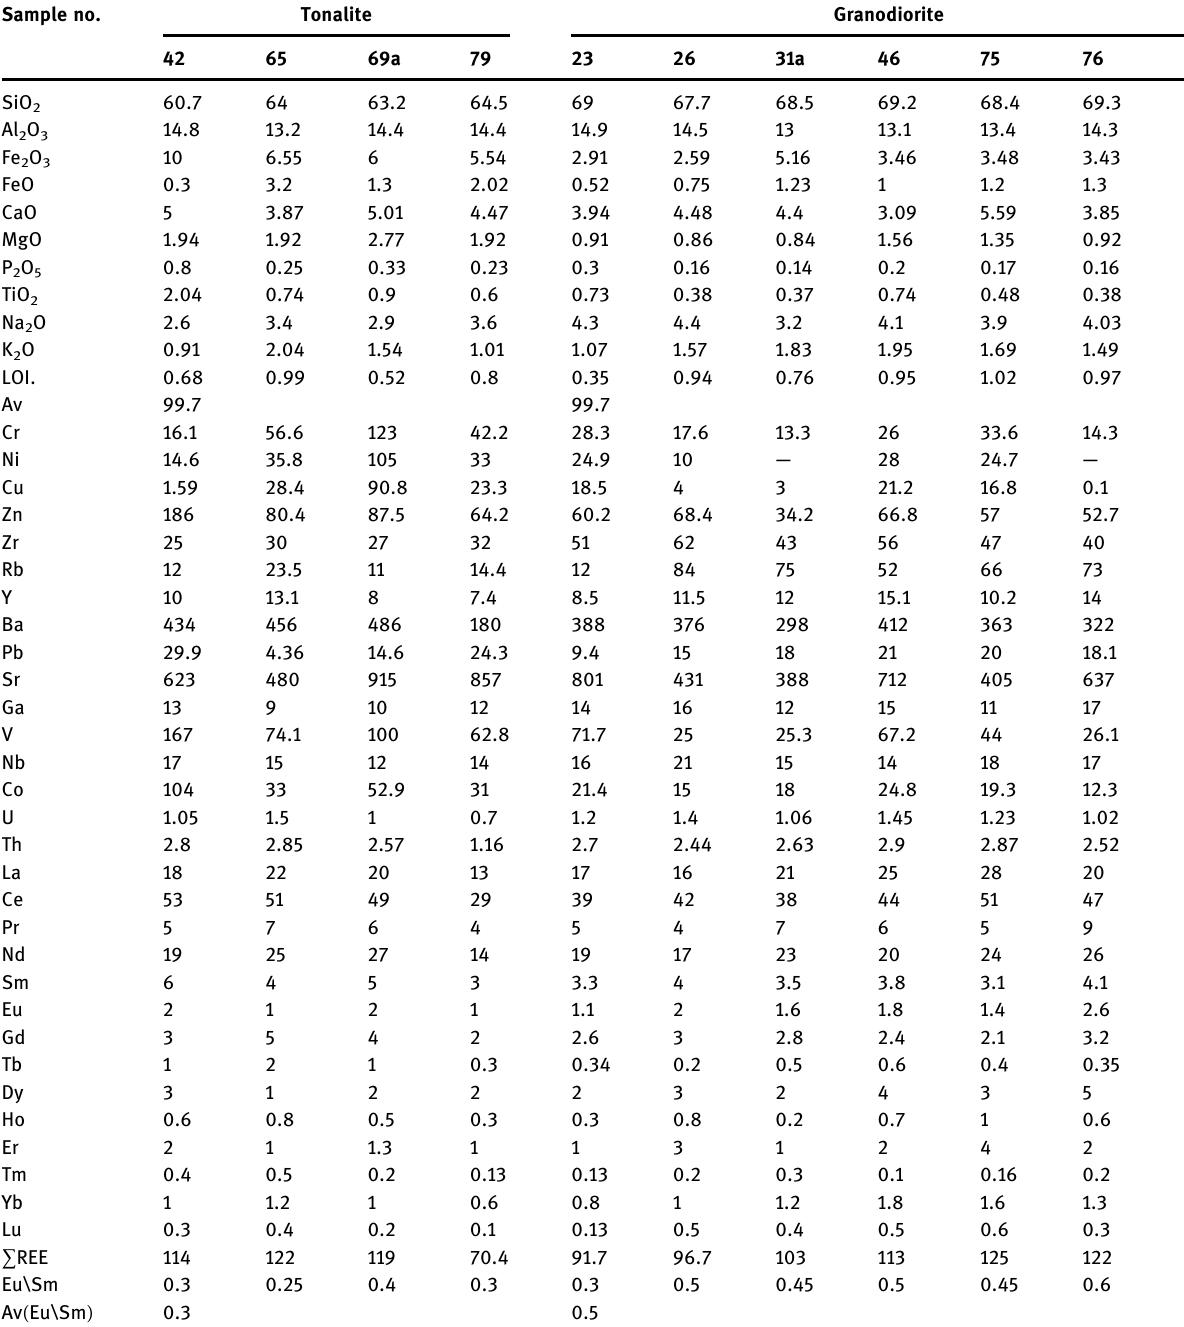
Table 2: Major oxides, trace and REE of tonalite and granodiorite Sample no.